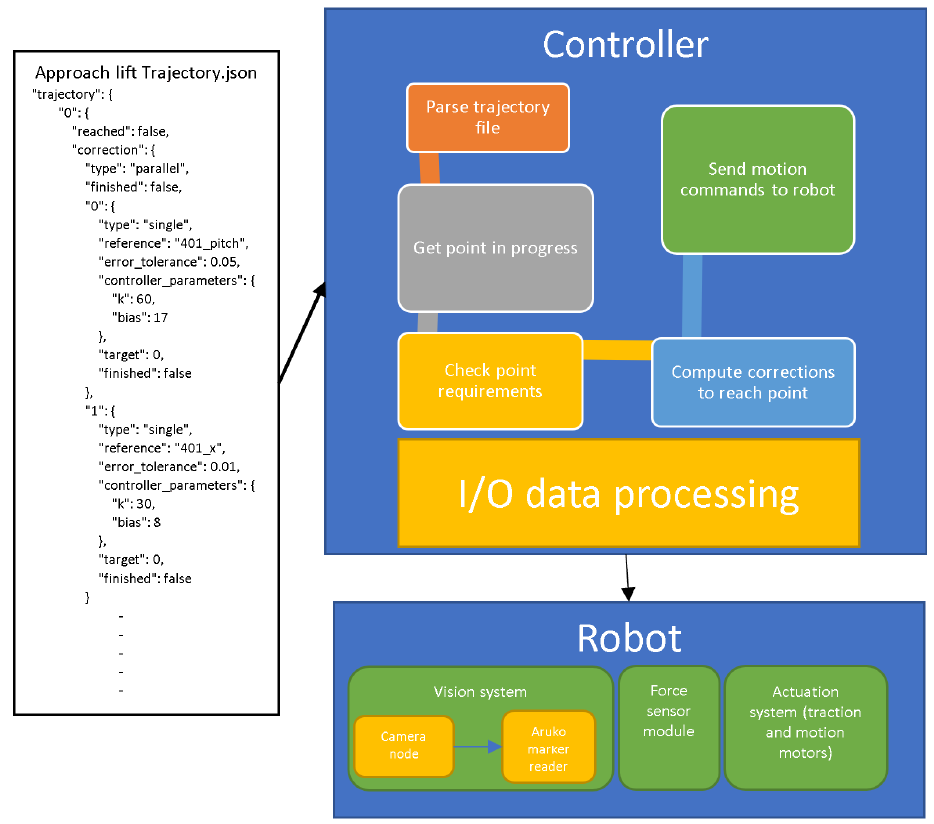
Figure 2. Software